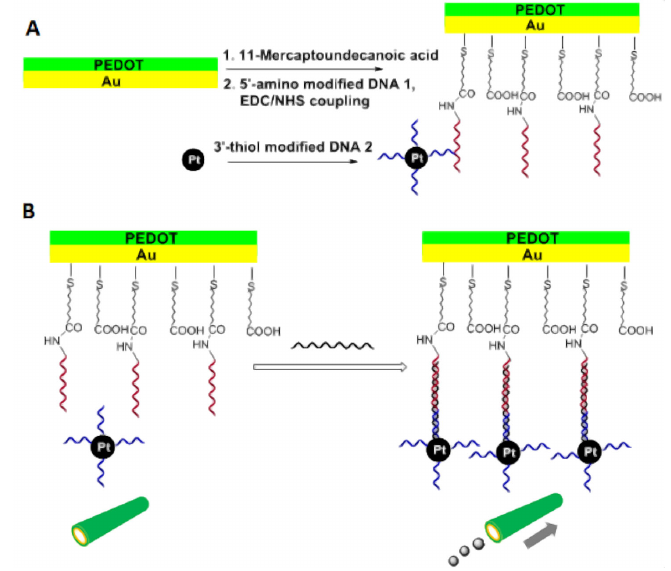
Figure 6. ( A ) Modification of the inner surface of poly(3,4 ‐ ethylenedioxythiophene) (PEDOT) on Au microtubes with capture DNA, and of Pt nanoparticles with detector DNA; ( B ) The principle for DNA detection by introducing Pt nanoparticle ‐ DNA conjugates into the microtubes via specific DNA hybridization mediated by target DNA; Figure reproduced with permission from Ref. [51].